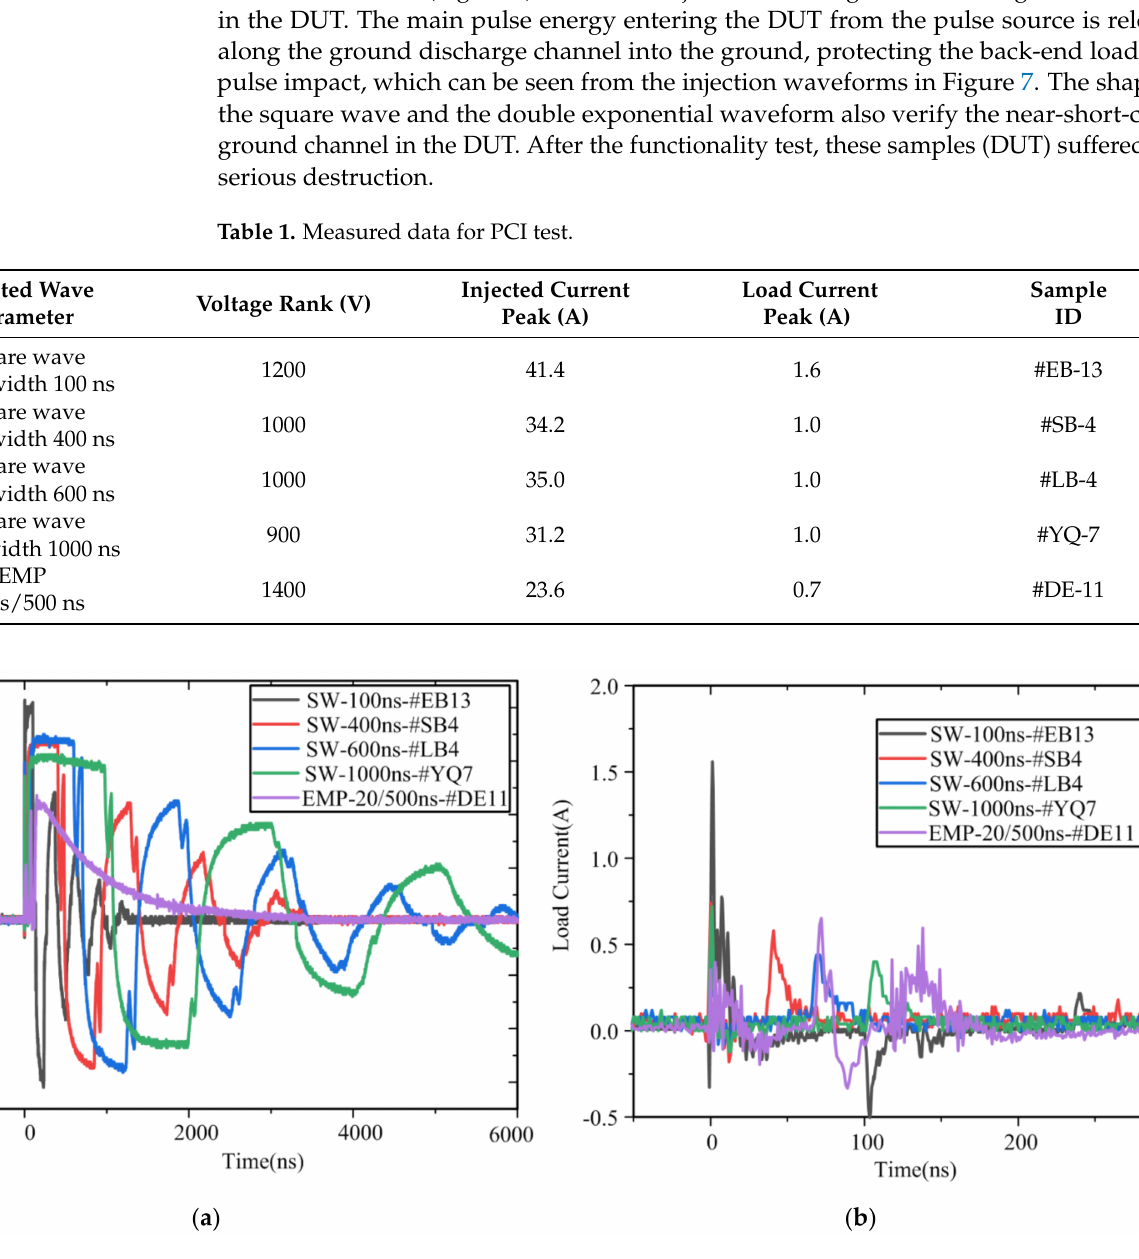
Figure 7. Typical current waves of PCI test: ( a ) injected current waves; ( b ) load current